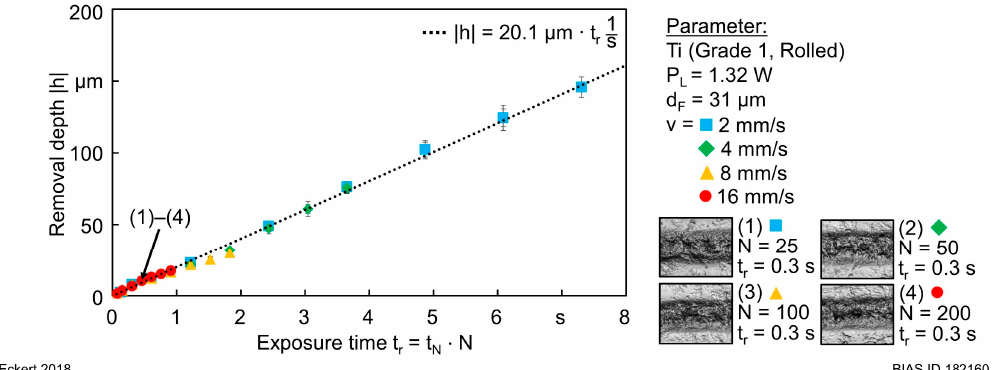
Figure 11. Removal depth over the exposure time t r for different scan velocities.